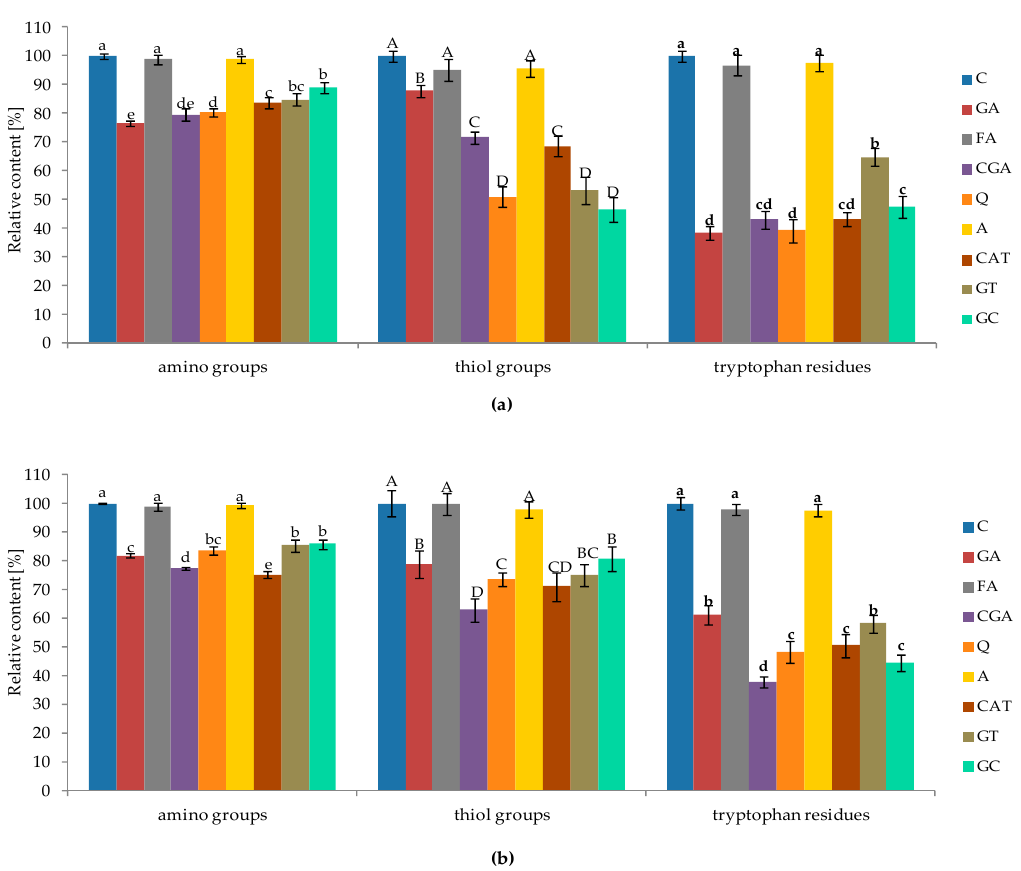
Figure 2. The effect of phenolic compounds on the relative abundance of free amino groups, thiol groups, and tryptophan residues of proteins: ( a ) albumins; and ( b ) globulins. Bars represent means ± SD. Means ( n = 3), followed by different normal lowercase letters (a, b, c . . . ) for amino groups, uppercase letters (A, B, C . . . ) for thiol groups, and bold lowercase letters (a, b, c . . . ) for tryptophan residues, in bars are significantly different at α = 0.05. C–control sample, GA, FA, CGA, Q, A, CAT, GT, GC–protein samples after incubation with gallic acid, ferulic acid, chlorogenic acid, quercetin, apigenin, catechin, green tea, and green coffee extracts, respectively.